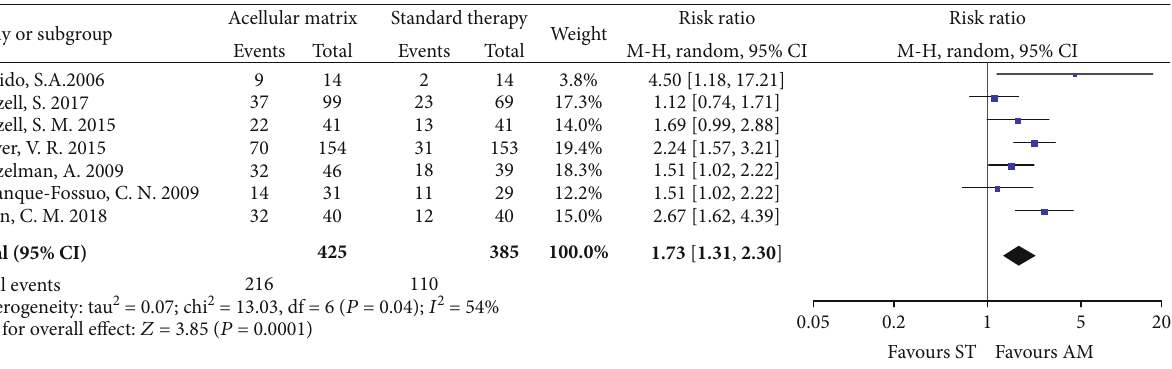
Figure 3: Forest plot of complete healing rate at 12 weeks.